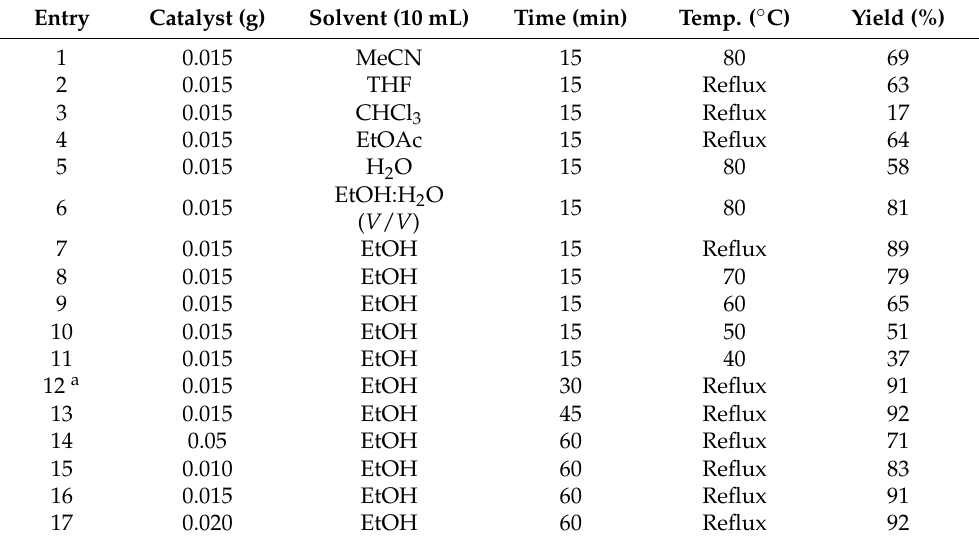
a Optimized reaction